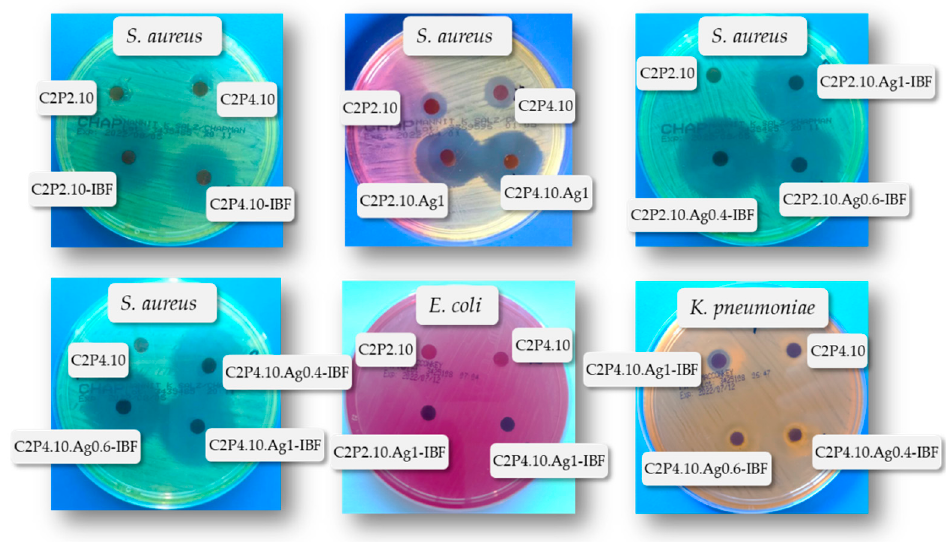
Figure 11. Antibacterial activity against S. aureus , E. coli and K. pneumoniae of film samples with and without the drug and with different percentages of AgNPs in the composition.